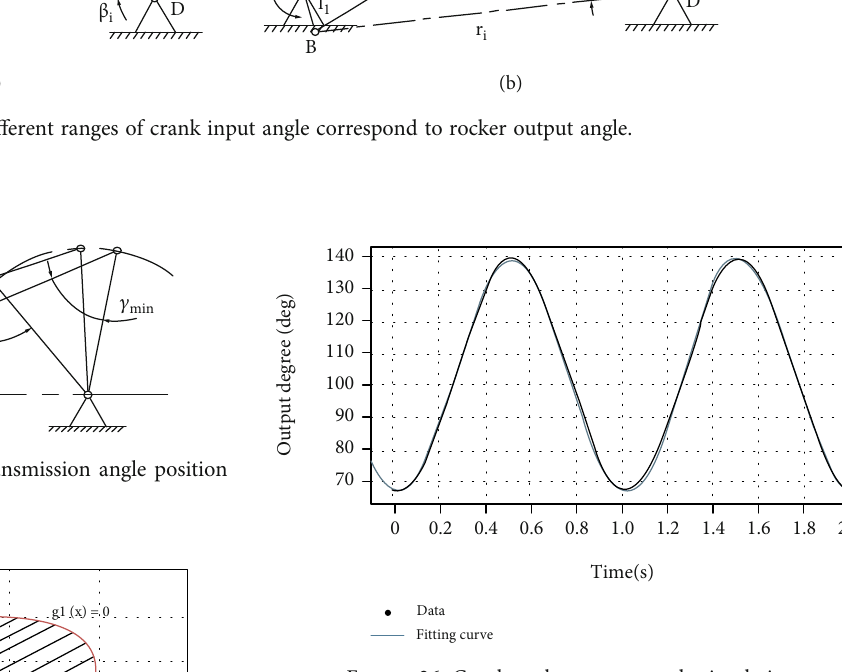
Figure 26: Crank-rocker output angle